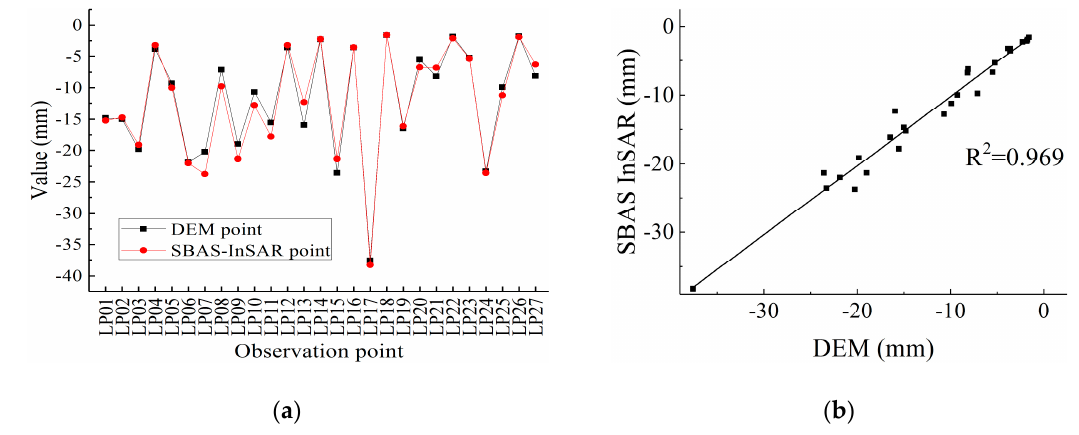
Figure 14. Comparison of the stable points of SBAS-InSAR and digital elevation model (DEM) results in 2007–2008 (( a ) the value of observation points; ( b ) the coefficient of determination).